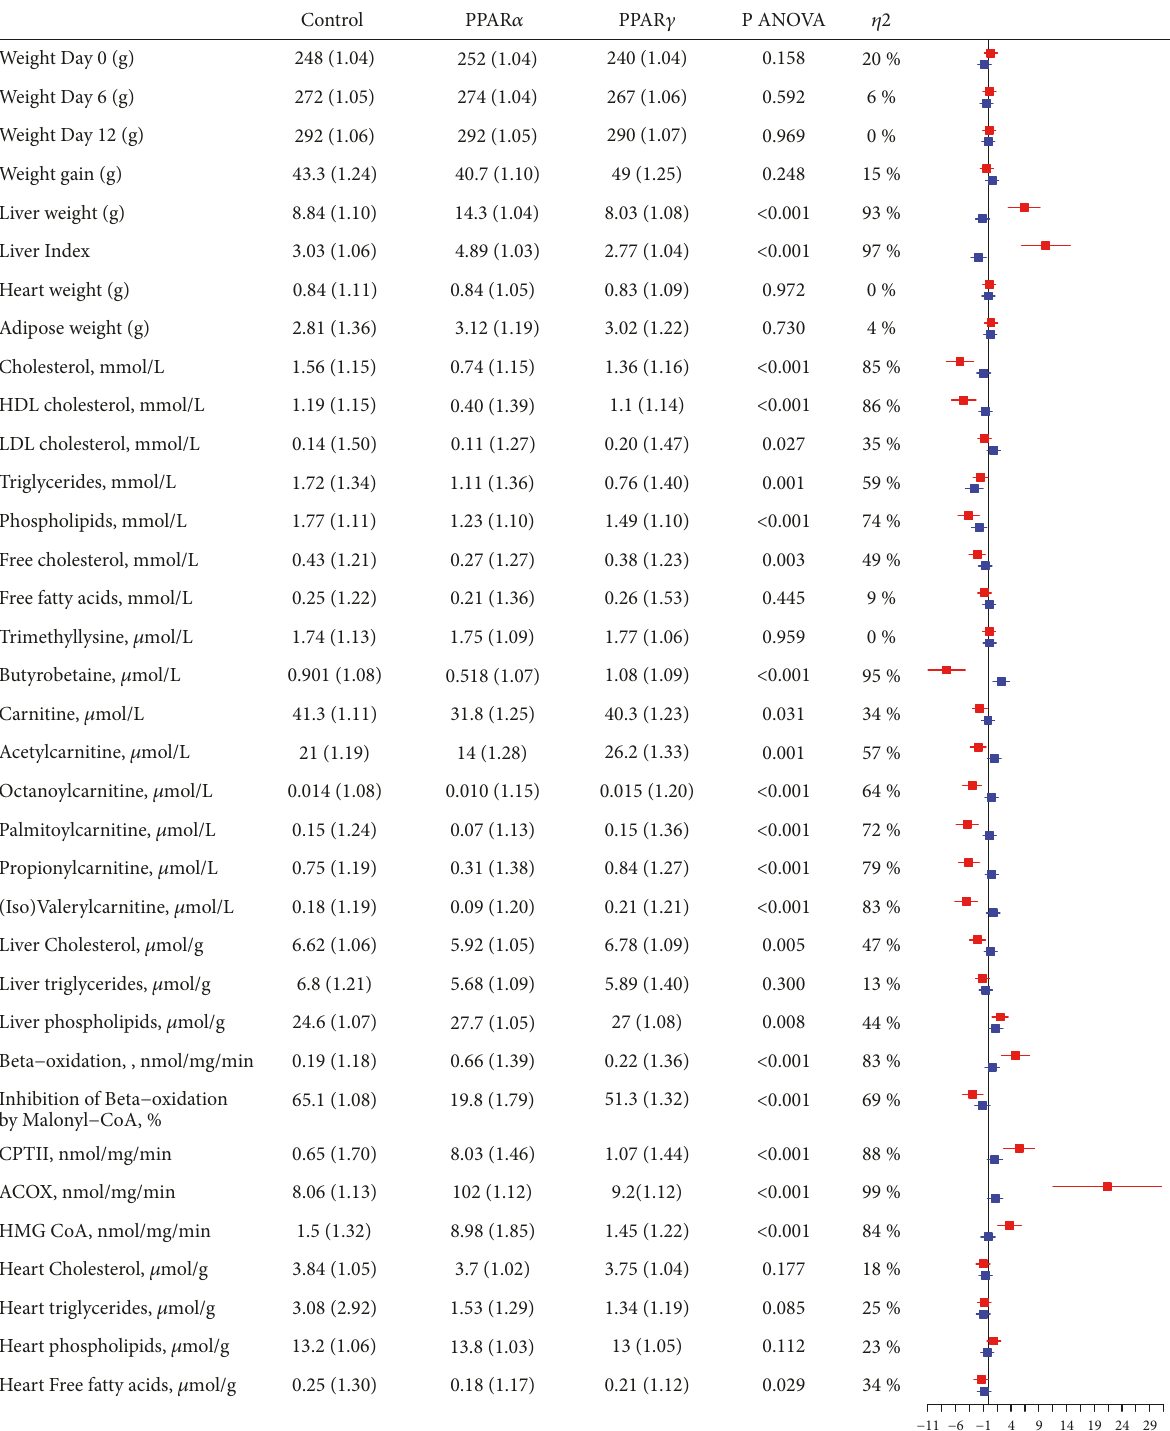
Figure 1: Weights and lipid related parameters in Wistar rats during treatment with PPAR agonists for 12 days. Values are geometric mean (gSD).RedbarscorrespondtoPPAR 𝛼 vscontrolandbluebarstoPPAR 𝛾 vscontrol.Measurementsofvariablesareinplasma,unlessotherwise stated. ACOX, fatty acyl-CoA oxidase; ANOVA, analysis of variance; CPTII, carnitine palmitoyltransferase II; EPI, epididymal fat; HDL, high density lipoprotein; HMG-CoA, 3-hydroxy-3-methylglutaryl-coenzyme A synthase; LDL, low density lipoprotein; PPAR, peroxisome proliferator-activated